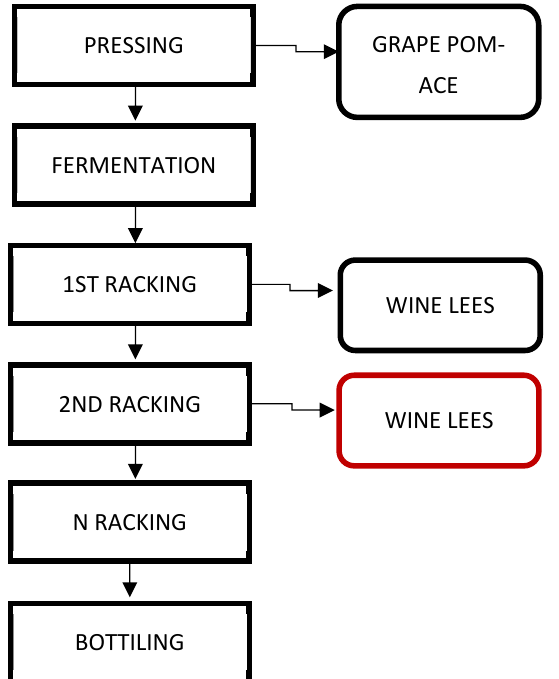
Figure 1. Vinification process from which wastes are produced, Inside the red box, the type of less received from Belisario Winery.